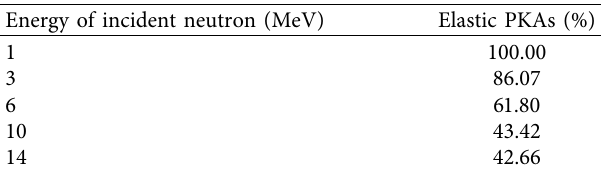
Table 1: The proportion of PKAs generated by elastic scattering